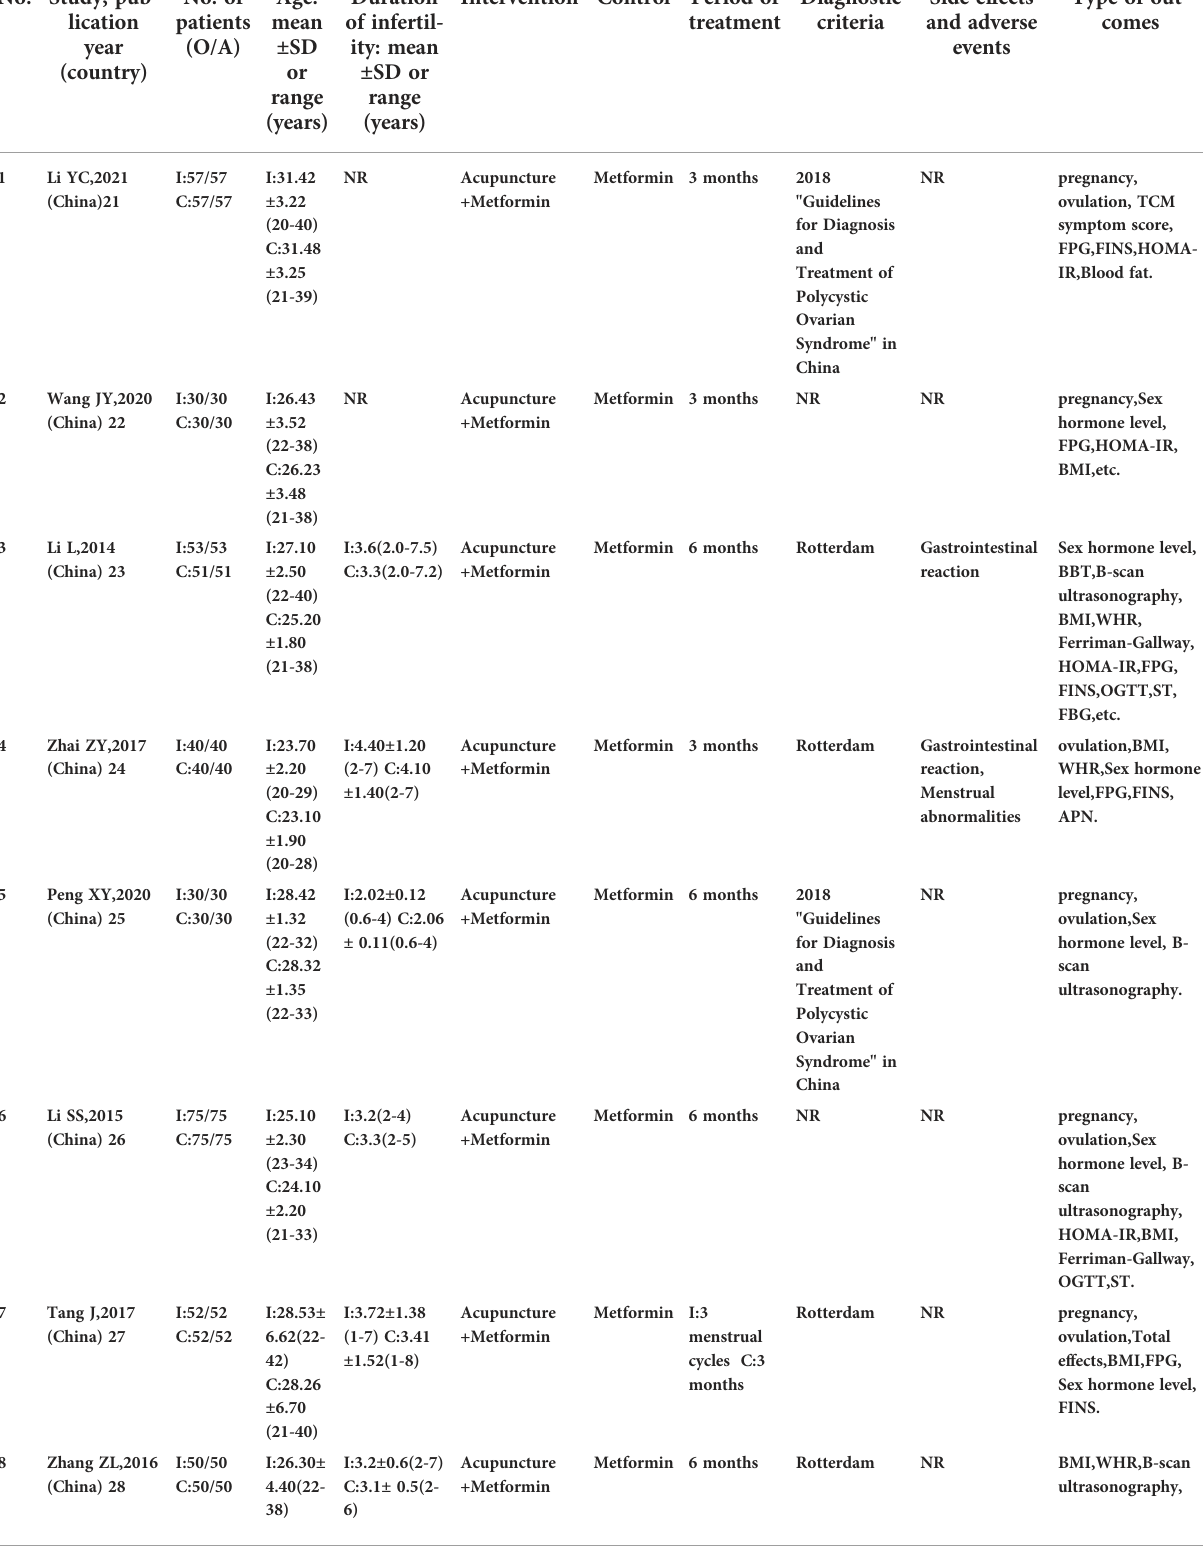
TABLE 1 Characteristics of the studies included in this systematic review (acupuncture + metformin vs. metformin). No. Study, pub-